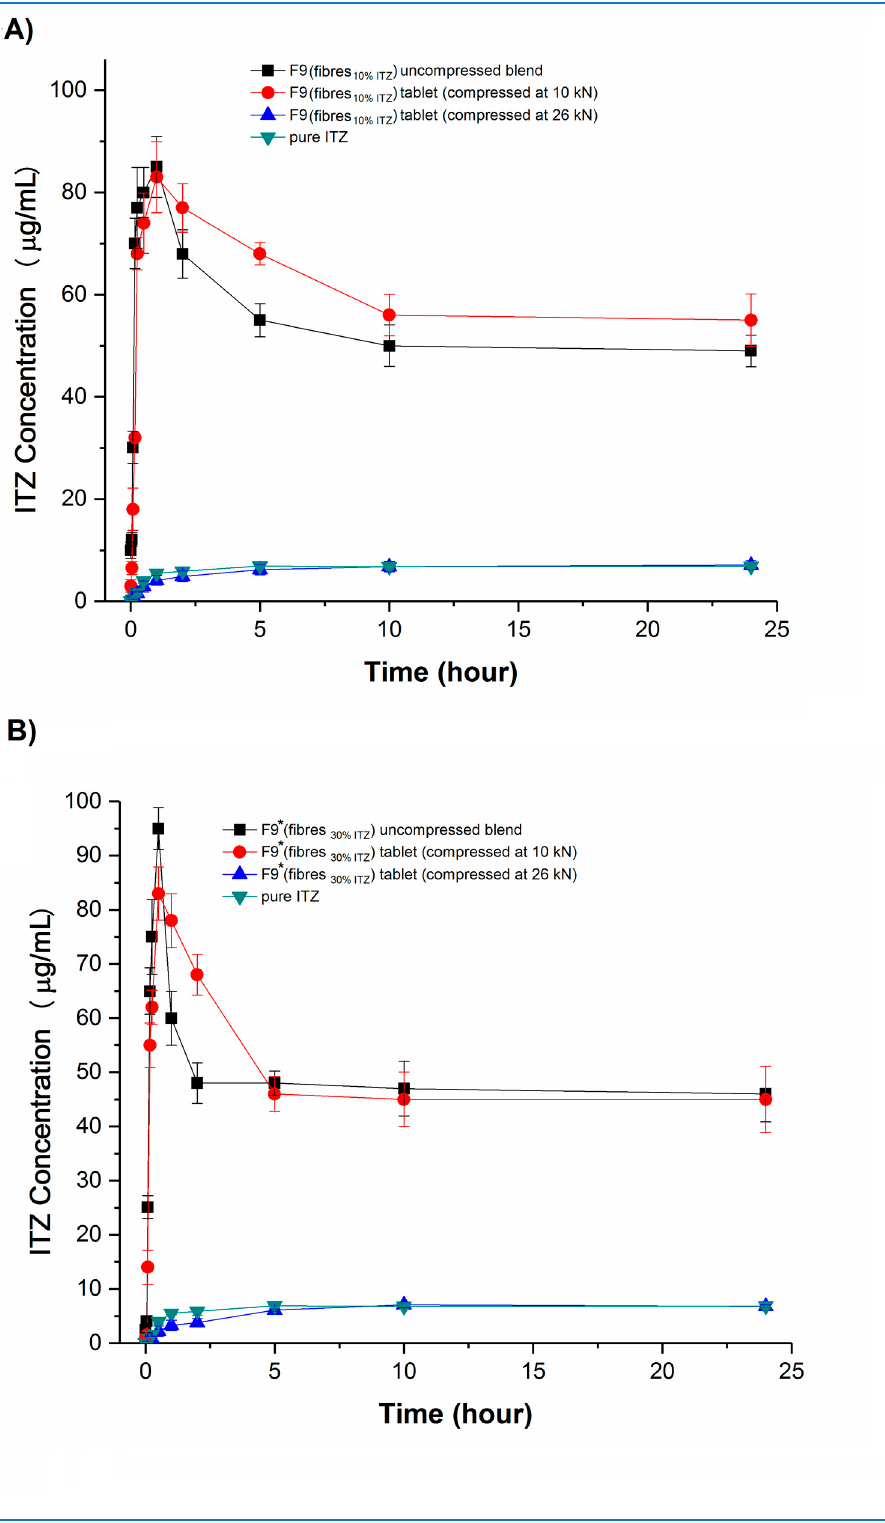
Figure 11. Dissolution–supersaturation profiles obtained under non-sink conditions for tablets, the corresponding uncompressed blends, and pure crystalline itraconazole. ( A ) F9 tablets, and ( B ) F9* tablets. (ITZ = itraconazole).